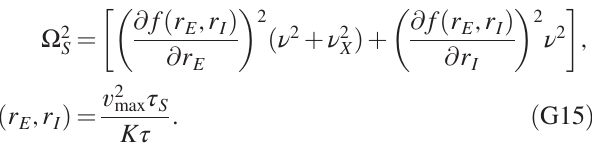
FIG. 17. Effect of short-term plasticity on single-neuron re- = τ . FIG. 16. Approximation of network response for large τ sponse. (a) Dependence of depression variable x S Plots analogous to Figs. 6(b) and 6(c) of the main text. Dots synaptic rate given by Eq. (H4), for different values of U . represent network response as a function of input rate ν , (b) Effective membrane time constant τ X 1 ms computed numerically from Eqs. (1) and (23) for τ depression variable as in (a). Short-term plasticity limits the S ¼ 10 ms (red). Continuous lines correspond to the (green) and τ decrease of τ with inputs. (c) Firing rate of conductance- S ¼ prediction obtained with instantaneous synapses (black) based neurons computed numerically as in Fig. 6(a), but with and for large synaptic time constant [Eqs. (G12), (5), and depression variable as in (a). Even with short-term plasticity, (G13), colored lines]. As explained in the text, the latter single-neuron response is suppressed for large ν = τ ; because of this, we predictions are valid only for large τ τ S = τ > 1 . For τ = τ ≫ 1 , the plot only values obtained for τ and γ ¼ 1 = 4 S S network response is well described by Eq. (21) of the main text.